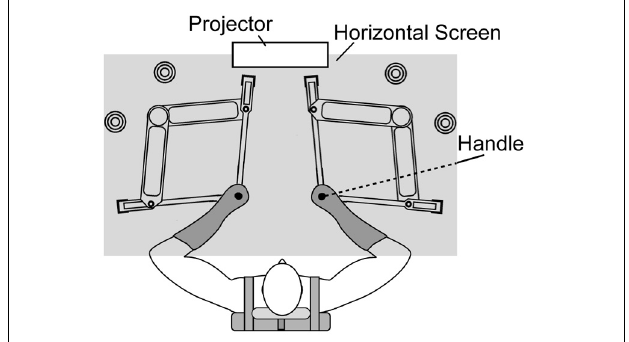
FIGURE 1 | Top-down view of twin visuomotor and haptic interface system (TVINS). In Experiment 1, only the right-hand manipulandum was used. In Experiment 2, both manipulanda were used. The horizontal screen is illustrated as if it were transparent in order to show the manipulandum. In reality, it was opaque and reflected images generated by the projector installed